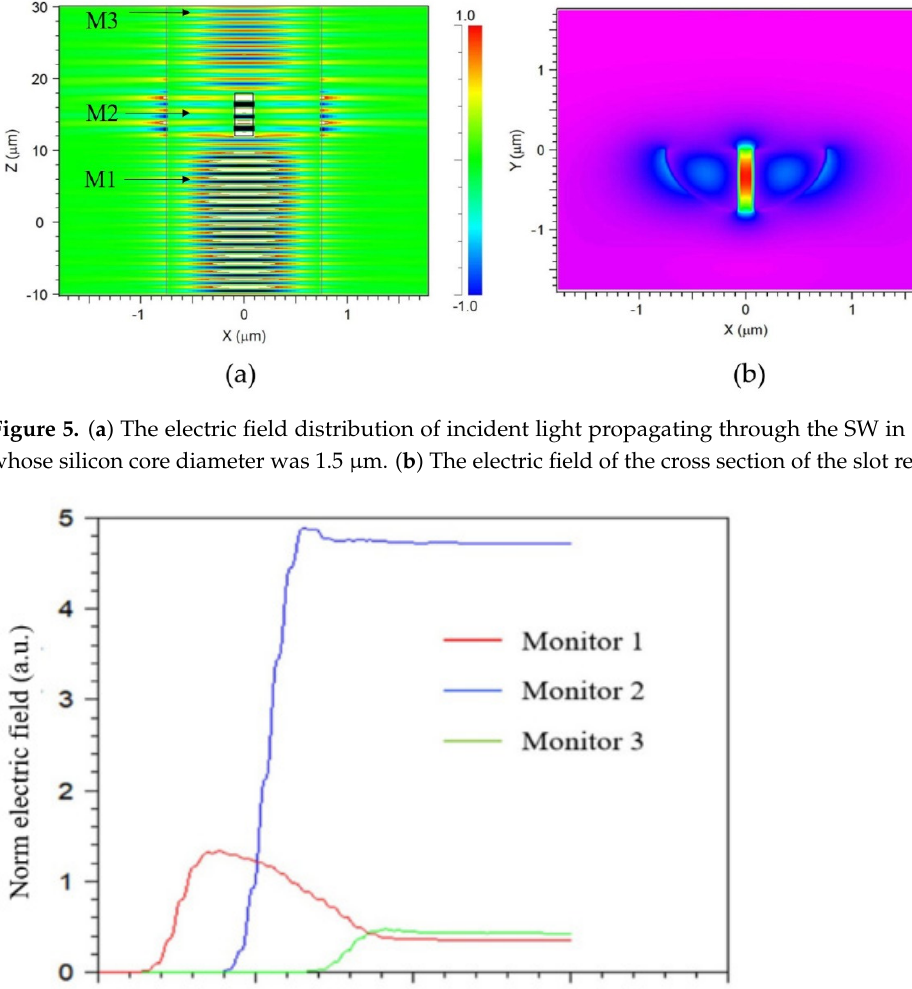
Figure 6. The evolution of norm electric field of SW in DSCF. The red, blue and green curves were the monitored |𝐸| value at location M1, M2 and M3, respectively.